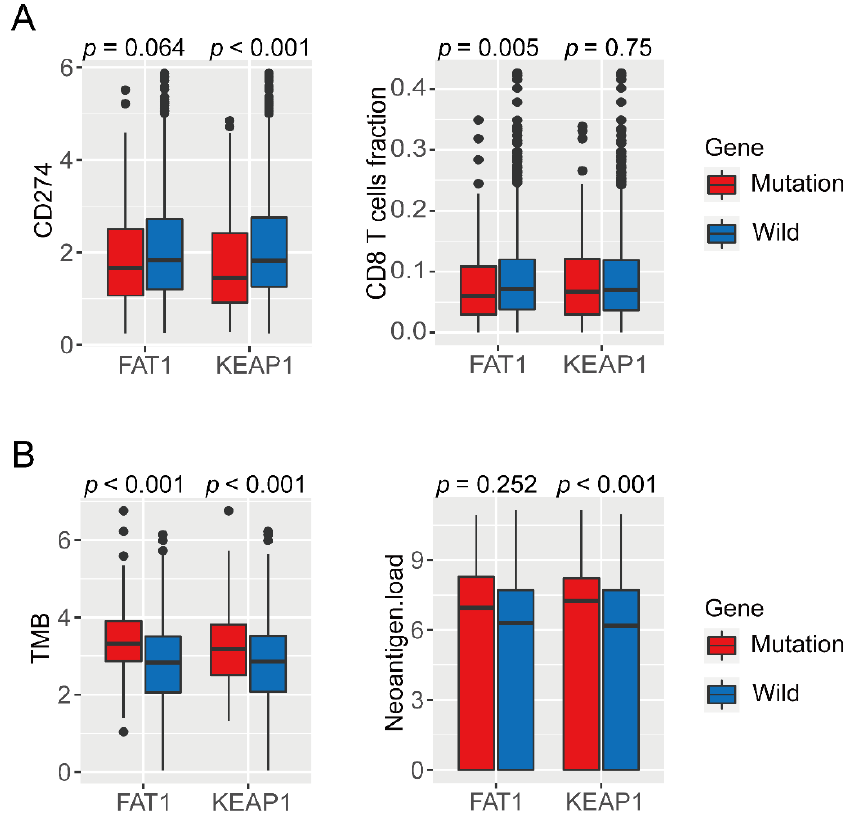
Figure 2. Correlation between gene mutation and status of common biological indicators in patients treated with immune checkpoint blockade (ICB). ( A ) Left: mRNA expression of CD274, right: CD8+ T cell infiltration; ( B ) left: tumor mutation load, right: neoantigen load.